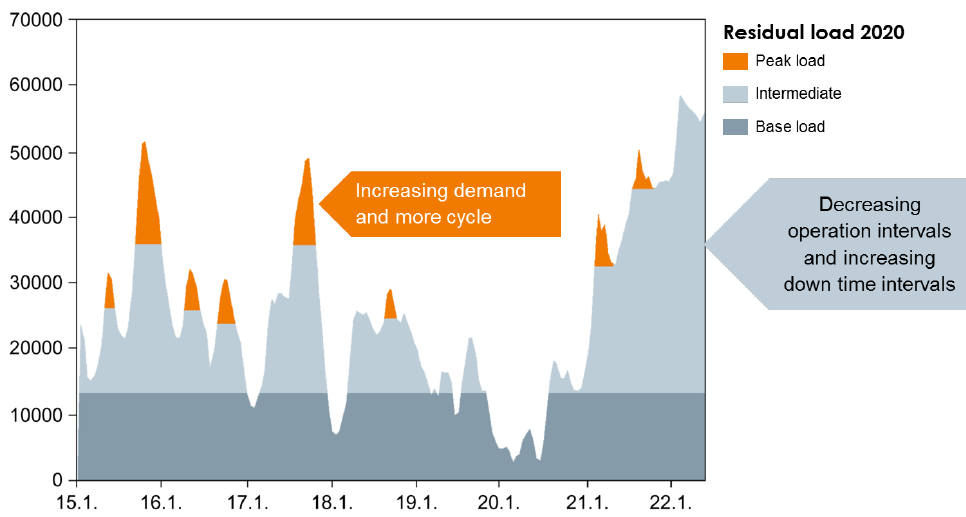
Figure 7. Residual-load demand 2020 – Expected growth in the peak-load operating range.